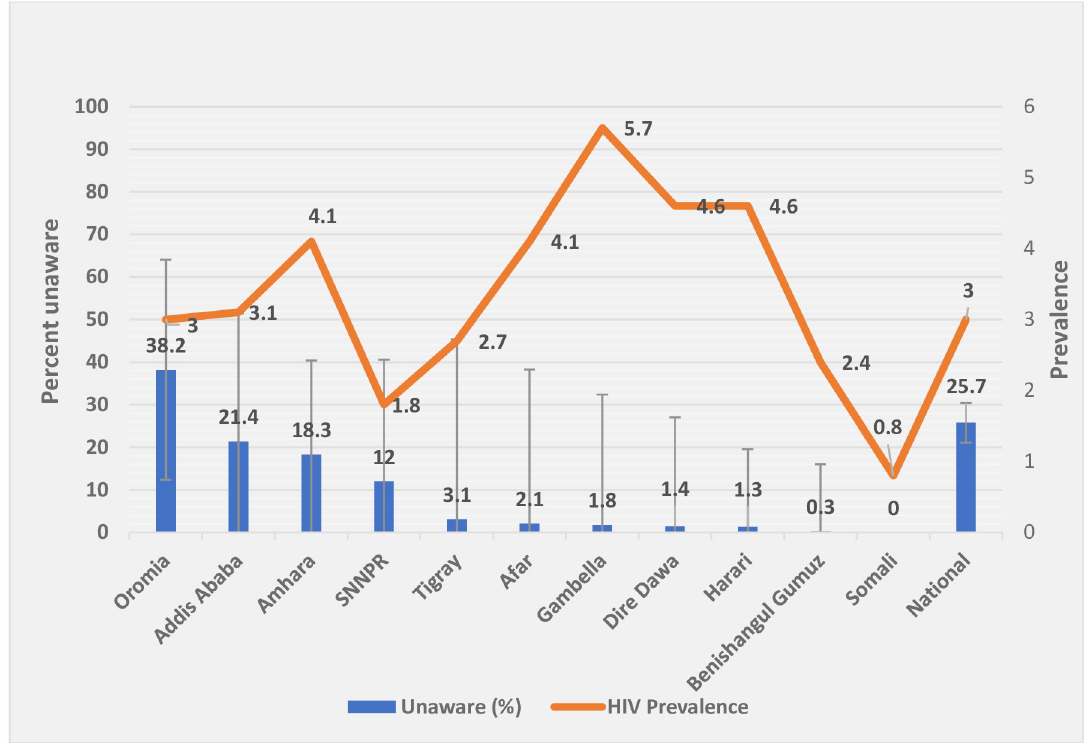
Fig 3. The burden of unawareness status by region among HIV-positive participants aged 15–64 in urban Ethiopia, 2017/18.